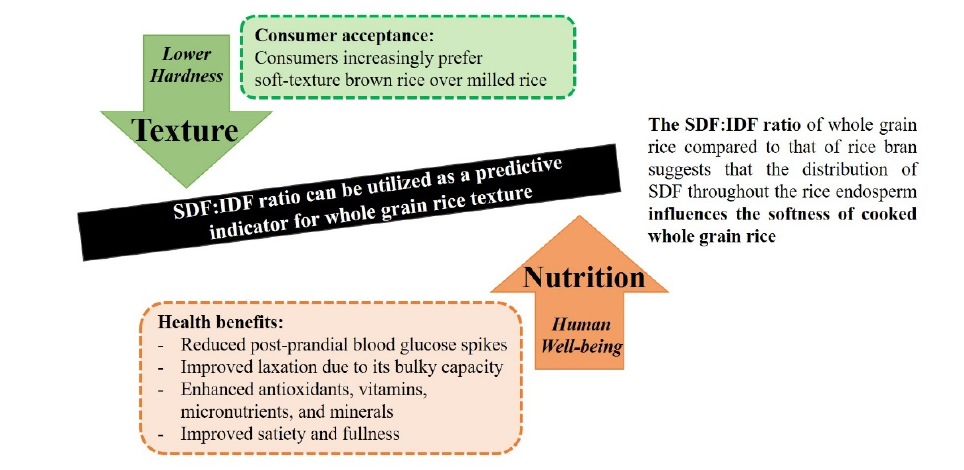
Figure 7. Conceptual diagram summarising the framework of this research. Supplementary Materials: The supplementary material for this article can be found online at www.mdpi.com (cid:1) xxx (cid:1) s1, Figure S1: Linear regression between the dietary fibre content and the bran layer weight determined by the alkaline method; Figure S2: Linear regression between the dietary fibre content and the bran weight determined by the milling method; Table S1: Rice bran traits of whole grain rice samples; Table S2: Physical characteristics of whole grain rice samples; Table S3: Chemical compositions of whole grain rice samples; Table S4: Chemical compositions of milled bran samples; Table S5: Pearson’s correlation matrix; Table S6: Texture profile analysis of cooked whole grain rice samples; Table S7: Genotype of rice samples; Table S8: Range of basic nutrient composi ‐ tions of whole grain rice, milled rice, and rice bran; Table S9: Comparison of the β‐ glucan and pectin content in whole grain rice and rice bran. Author Contributions: S.W. and A.V. conceived and designed the work. A.V. and W.K. supervised the research. S.W., R.W., and E.C. performed the experiments and conducted the statistics data anal ‐ ysis. S.W. and A.V. wrote and revised the manuscript. All authors contributed to the article. All authors have read and agreed to the published version of the manuscript. Funding: This work was supported by National Science Research and Innovation Fund (NSRF) via the Program Management Unit for Human Resources and Institution Development, Research and Innovation (Grant No. B16F630088); Distinguished Research Professor Grant, The National Re ‐ search Council of Thailand; National Science and Technology Development Agency (NSTDA) (Grant No. P ‐ 18 ‐ 52711). SW was financially supported by Postdoctoral Fellowship Program from Kasetsart University Research and Development Institute. Data Availability Statement: The original contributions presented in this study are included in the article and Supplementary Materials. Further inquiries can be directed to the corresponding au ‐ thors. Conflicts of Interest: The authors declare no conflict of interest. References 1.